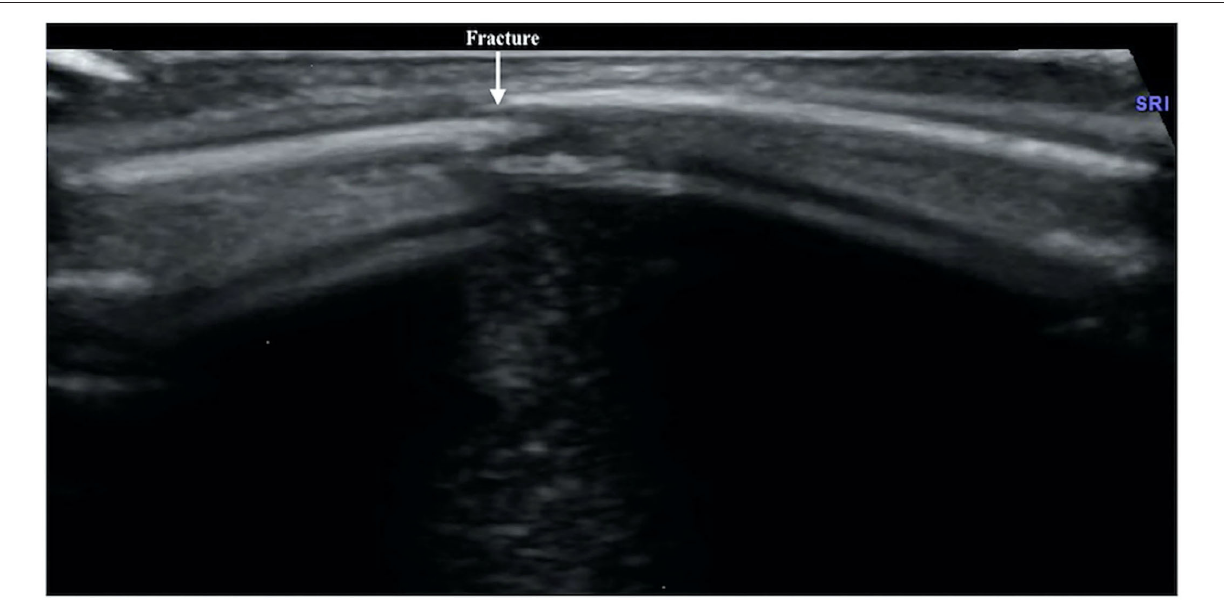
Frontiers in Pediatrics | www.frontiersin.org